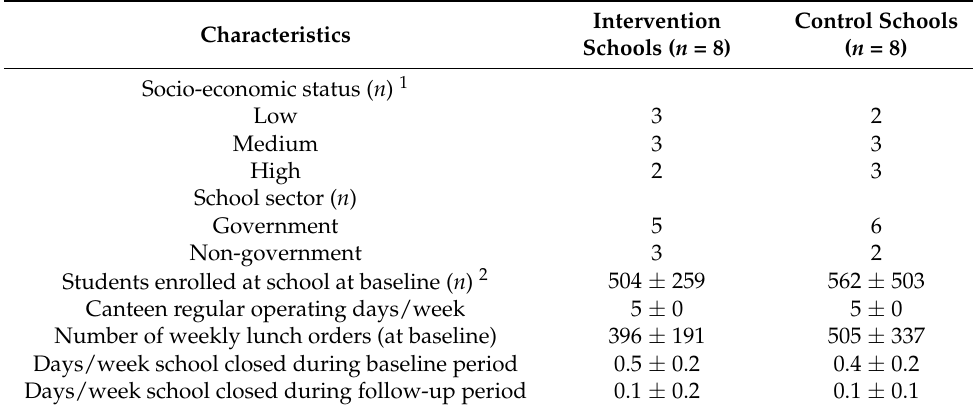
Table 1. Characteristics of participating schools who either implemented the multi-strategy behavioral intervention canteen strategies (intervention schools) or continued to offer their regular canteen menu (control